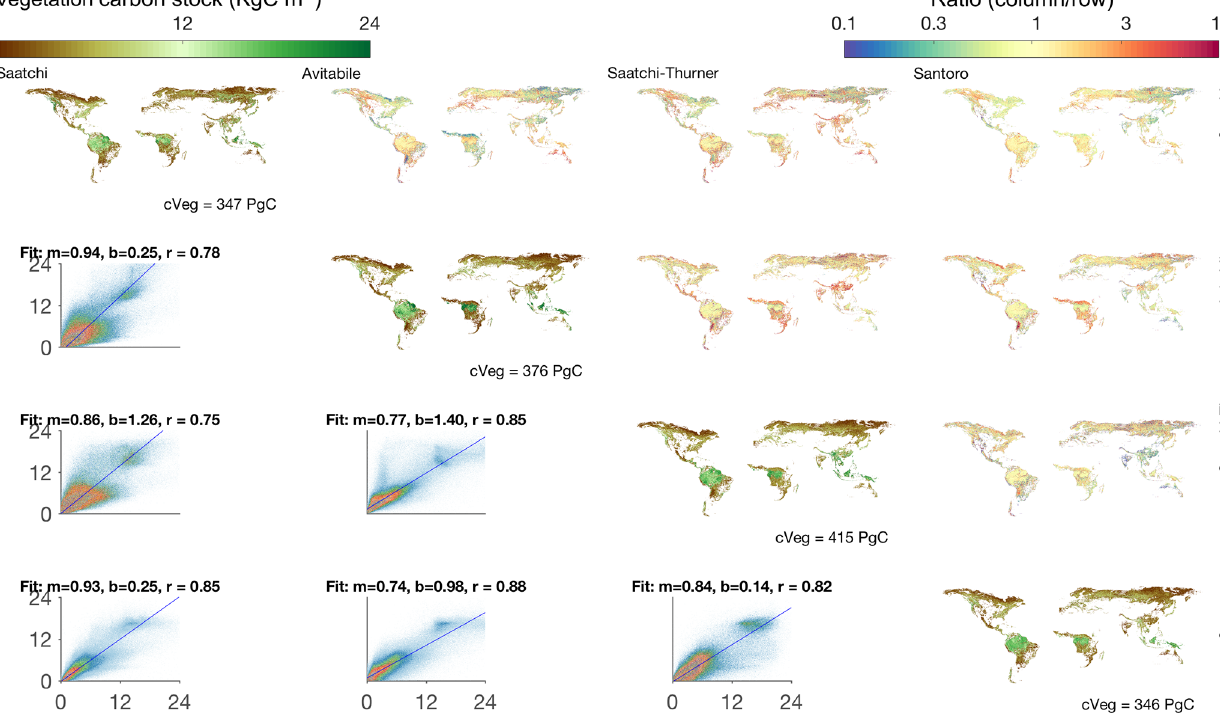
Figure 3. The same as Fig. 1 but for vegetation carbon stocks. The total vegetation carbon stock is calculated as the sum of aboveground (AGB), belowground (BGB) and herbaceous biomass. For consistency, only the grid cells where all four maps have values are included. Therefore, the total amounts in the diagonal panels differ slightly from those in Table